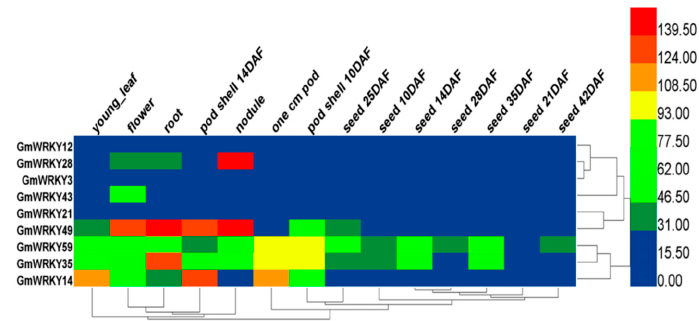
Figure 2. Expression pattern of nine GmWRKYs in six different tissues (young leaf, flower, pod shell, seed, root and nodule). The nine GmWRKYs were selected from salt treatment RNA-Seq data based on the rule that log 2 (NaCl_treat/CK2_treat) >1. The tissue expression is from SoyDB (http://soykb.org/). The color legend refers to the different expression level under normal condition. “DAF” in the tissue label indicates days after flowering.